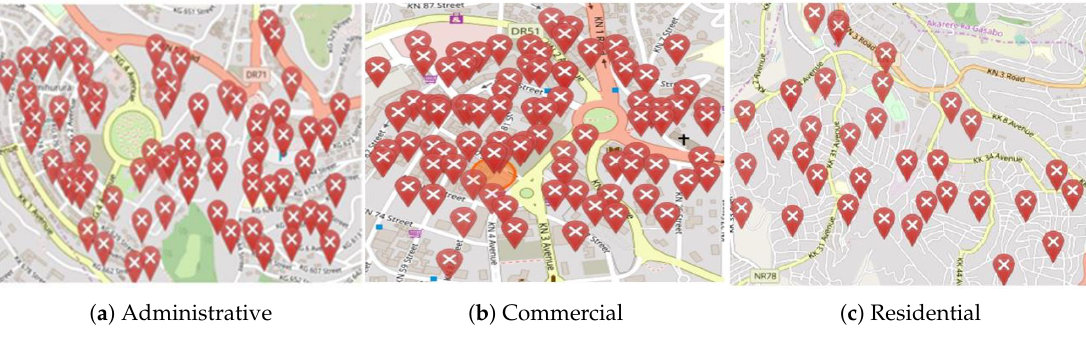
Figure 4. Area of Interest representation: OSM version.